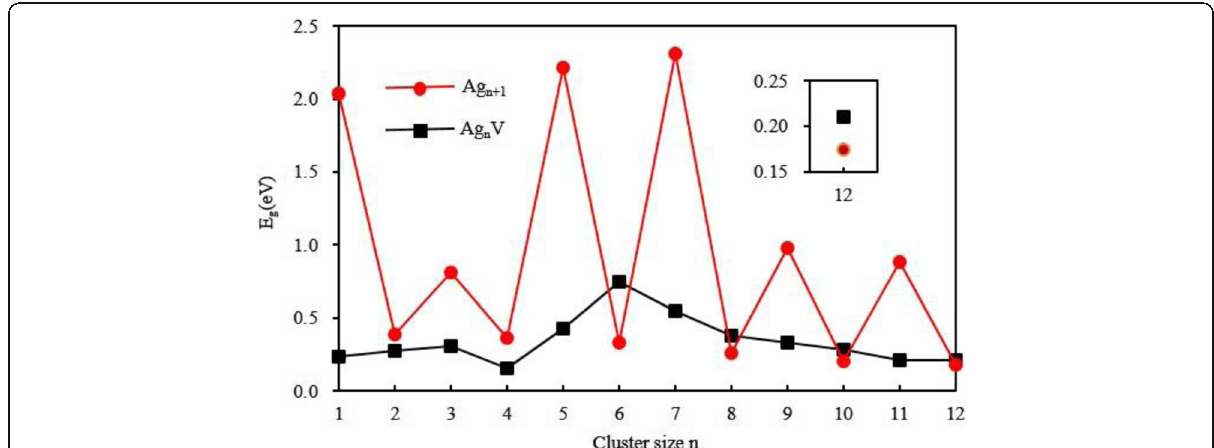
Fig. 6 The HOMO-LUMO energy gaps of the ground state Ag n +1 and Ag n V ( n =1 – 12)